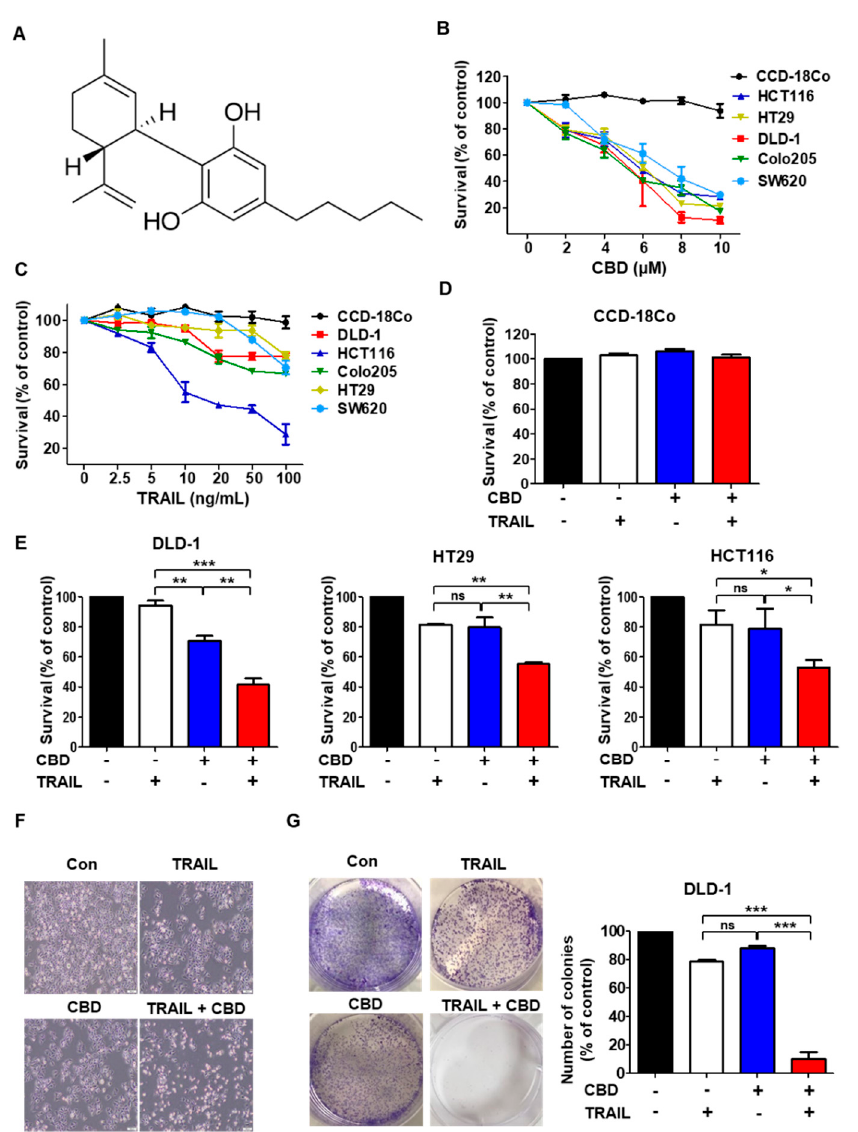
Figure 1. Cytotoxic assay of colorectal cancer cells after exposure to cannabidiol in combination with TNF-related apoptosis-inducing ligand (TRAIL). ( A ) Structure of cannabidiol. ( B ) Various cell lines were treated with cannabidiol for 24 h. ( C ) Cells were exposed to TRAIL for 4 h. ( D ) CCD-18Co (normal colon) cells were pretreated with or without 4 μ M cannabidiol for 24 h and then with TRAIL 10 ng/mL for 4 h. Cell survival was determined ( E ) DLD-1, HT29, and HCT116 cells were treated with cannabidiol (4 μ M) alone or in combination with TRAIL (DLD-1, HT29 10 ng/mL, HCT116 2.5 ng/mL). For parts B–E, cell survival was determined by the WST-1 assay. ( F ) Morphology of DLD-1 cells that were pretreated with or without 4 μ M cannabidiol for 24 h and then treated with TRAIL at 10 ng/mL for 4 h. 100×. ( G ) Clonogenic assay was assessed after 7 days of cannabidiol treatment alone or combined with TRAIL and wells were stained with crystal violet at the end of the experiment. Left; Photographs of wells in a representative experiment are shown. Right; percentage inhibition of colony formation after drug treatment. Each result is presented as the mean of 3 independent experiments * p < 0.05; ** p < 0.01; *** p < 0.001. CBD, cannabidiol; ns, not significant.